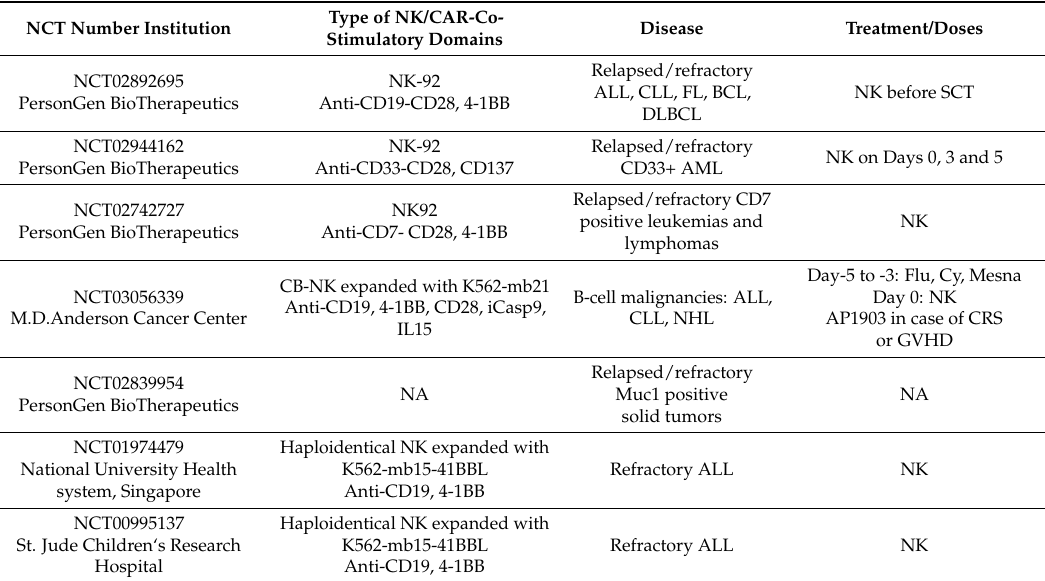
Table 2. Clinical studies on-going infusing CAR-NK cells in cancer